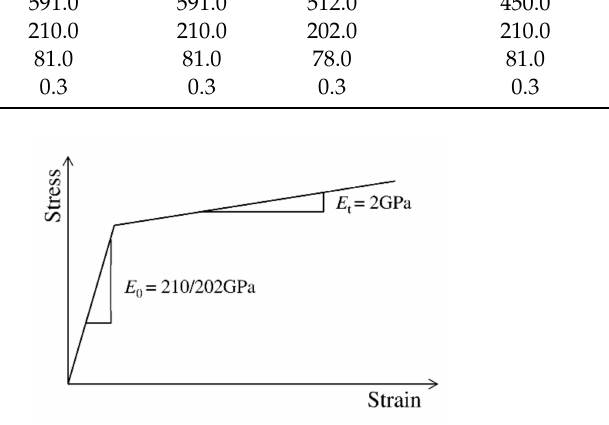
Figure 7. Bilinear steel model.